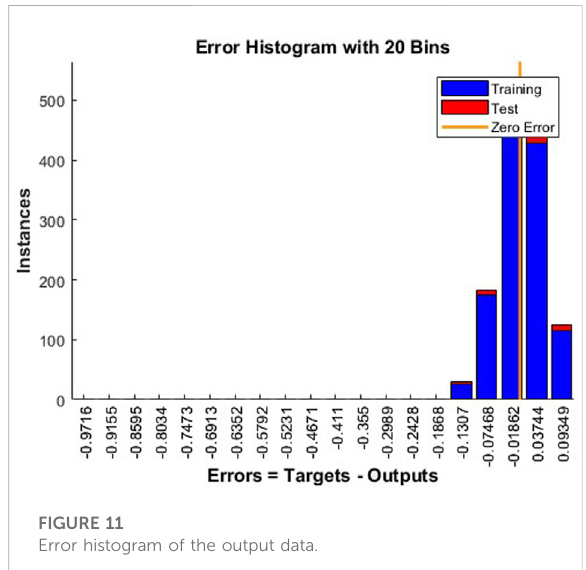
FIGURE 11 Error histogram of the output